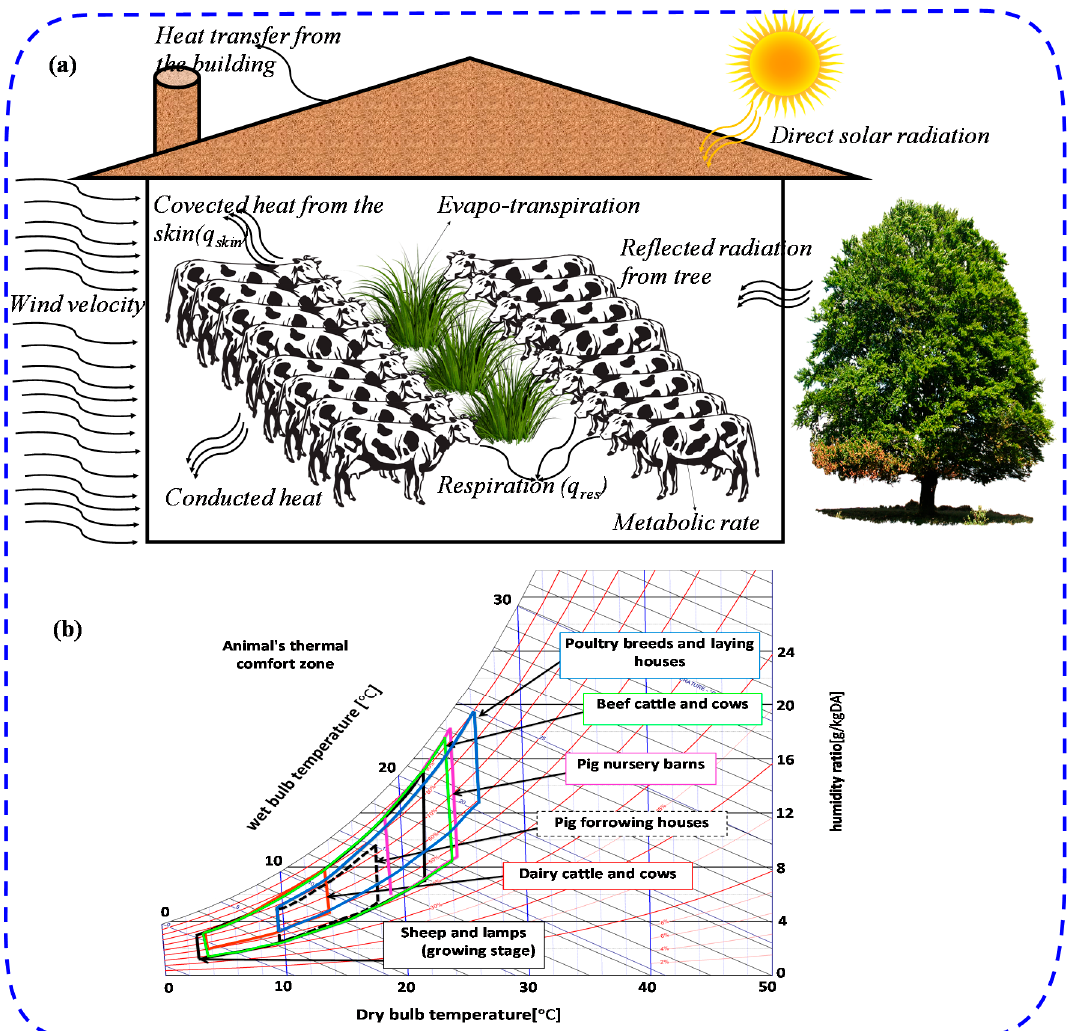
Figure 1. Livestock applications: ( a ) heat and mass transfer phenomena between farm animals and surrounding environment, adapted with permission from [42], IntechOpen, 2019; and ( b ) psychrometric illustration of thermal comfort regions for livestock animals, reproduced with permission from [38], IntechOpen, 2017.